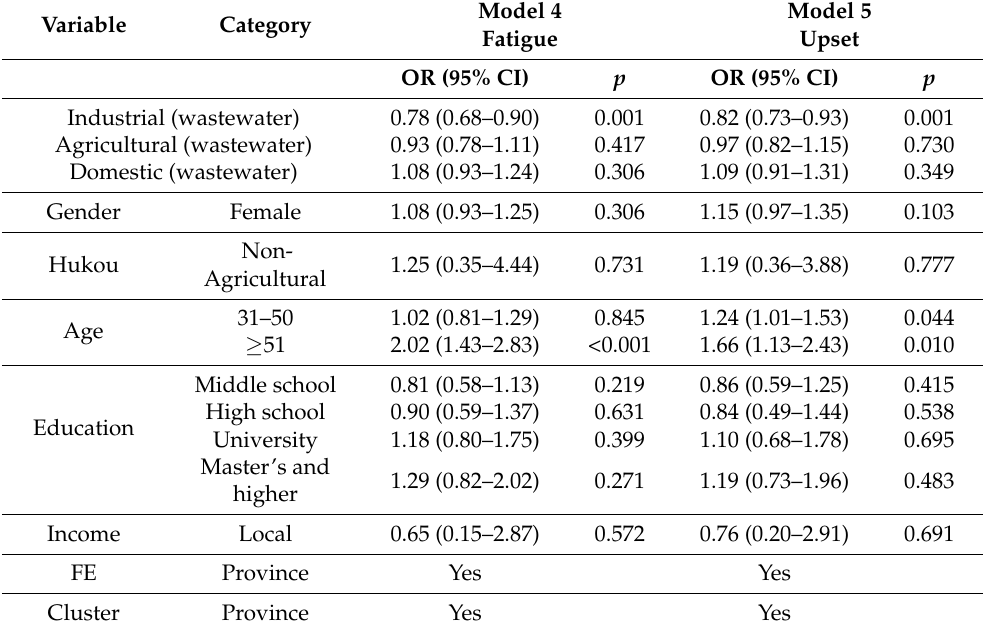
Table 4. The specific effects of wastewater pollution on individuals’ health